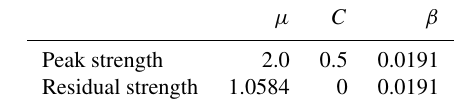
Table 3. Parameters used for fitting the failure surface constrained by Eq. (1) to our data and those of Wild and Amann (2018a). µ C β Peak strength 2.0 0.5 0.0191 Residual strength 1.0584 0